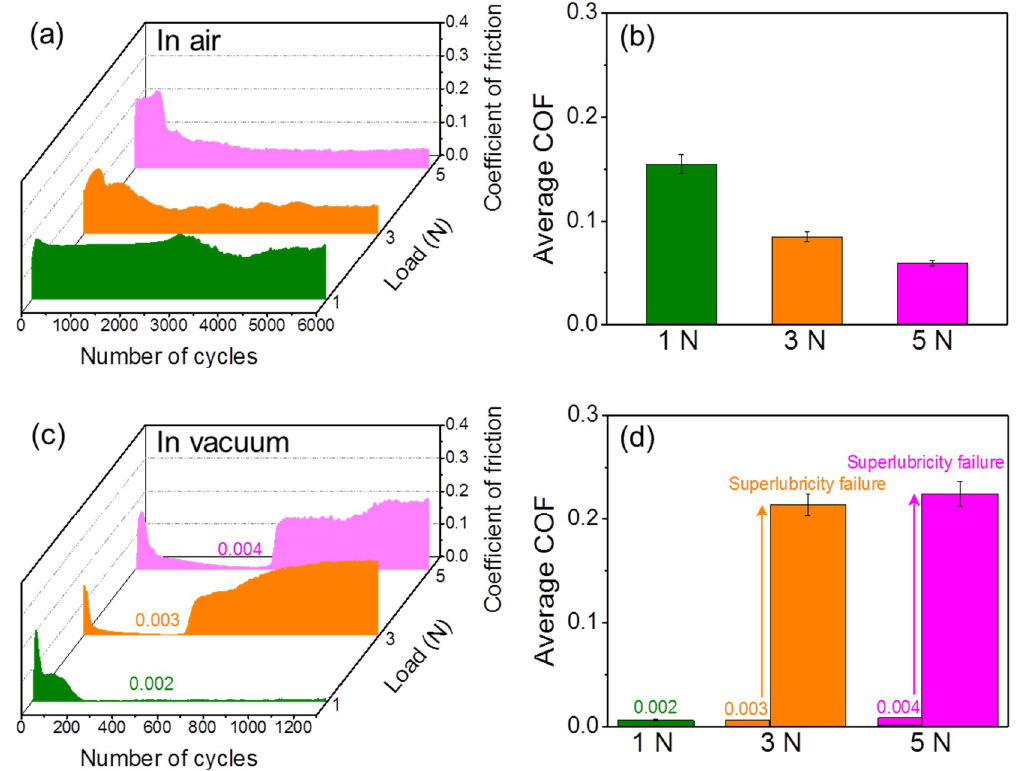
Figure 2. Friction behaviors of H-DLC films against Al 2 O 3 balls at different normal loads in ( a , b ) humid air and ( c , d ) vacuum. ( a ) and ( b ) respectively show sliding cycle dependence of friction coefficient and average friction coefficients in steady region as function of normal load in humid air. ( c ) and ( d ) respectively show friction coefficient curves and average friction coefficients in vacuum.